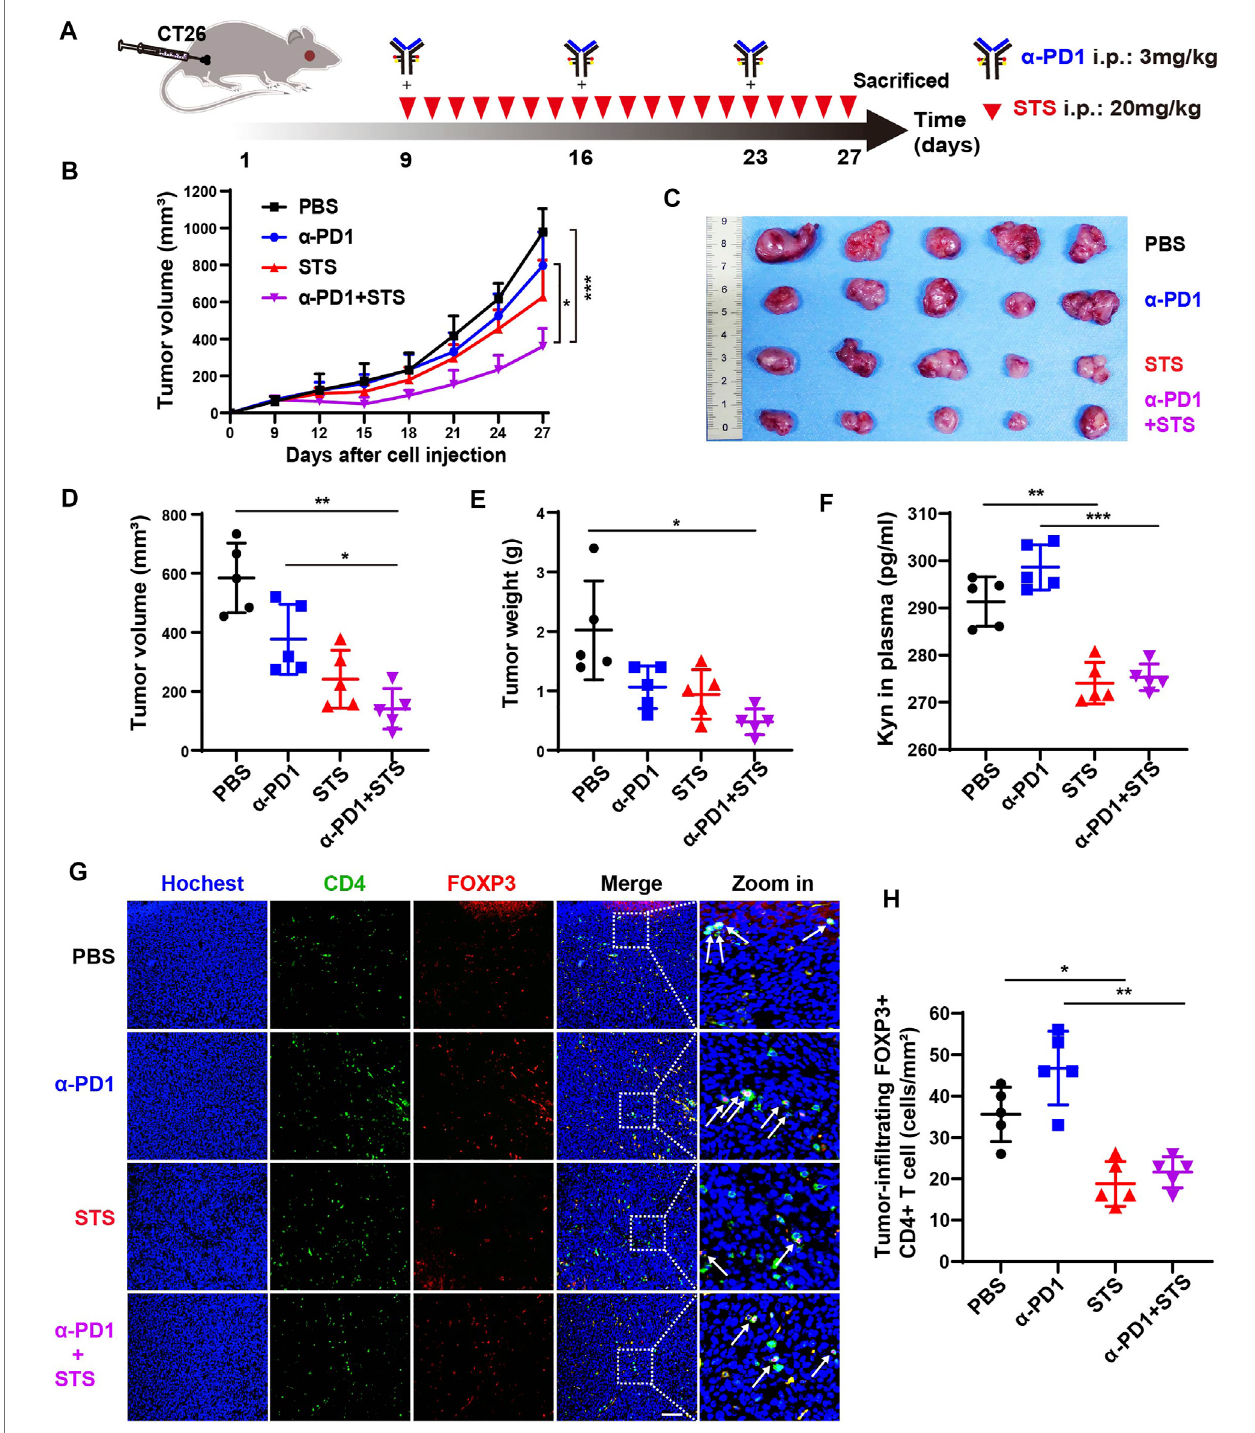
FIGURE4 | STS elevated theef fi cacyof anti-PD1 toinhibit CRC progression by decreasing the number ofTregs. (A) Schematic model illuminating methods ofthe murine CRC model establishment and therapy. Anti-PD1 ( α -PD1, 3 mg/kg): i.p. once a week. STS (20 mg/kg): i.p. once a day. The mice were sacri fi ced on day 27. (B) The average tumor growth curves for mice treated with phosphate-buffered saline (PBS), α -PD1, STS, and α -PD1 plus STS. The tumor volume was measured every 2 days. (C – E) The photograph, volum and weight of tumors on day 27. (F) Concentrations of kyn in plasma. It was measured by ELISA. (G) Immuno fl uorescence analysisoftumor-in fi ltratingCD4+TcellsandTreg(FOXP3+ CD4+)cellsafter therapy. Scalebar:100 μ m. (H) Statisticalanalysisofthenumber ofFOXP3+ CD4+Tcells ineach groupunderamicroscopeat×200magni fi cation. Statisticaldataarerepresented asthemean±SD.* p < 0.05,** p < 0.01and*** p < 0.001analyzedbyANOVA.